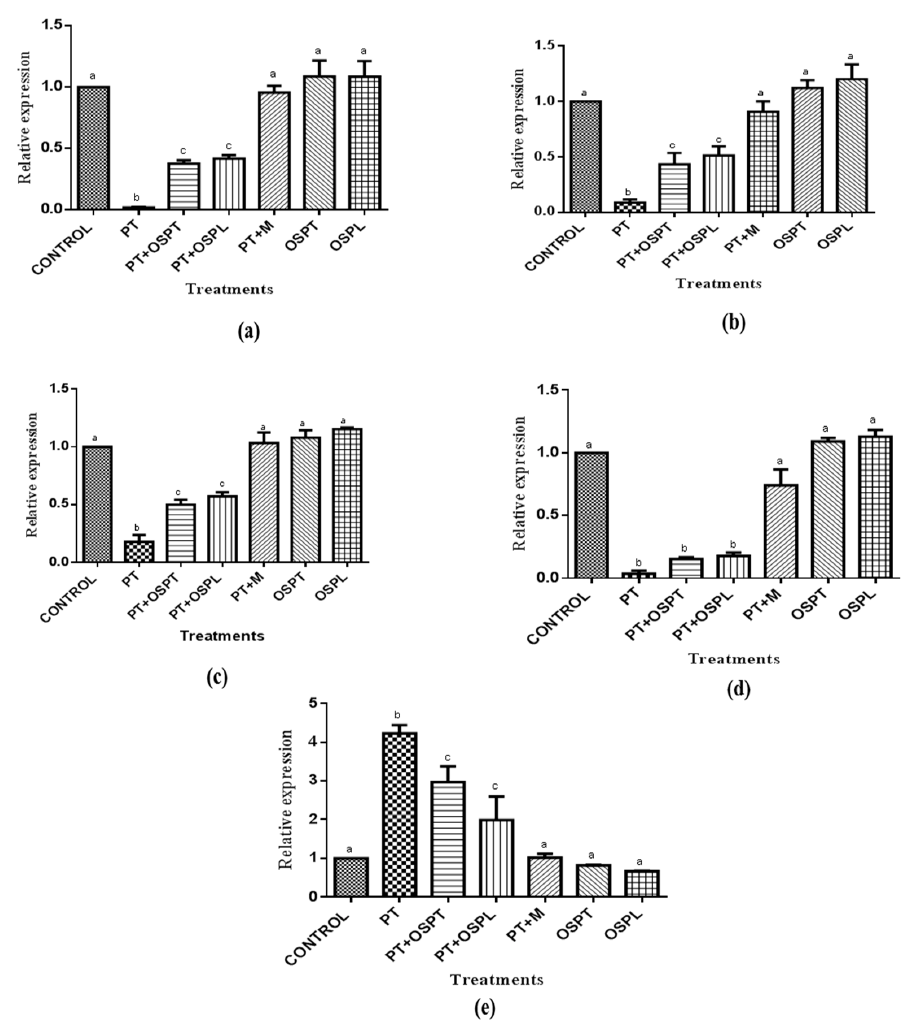
Figure 4. The effect of orange fleshed sweet potato extracts on the expression of ( a ) Glucose transporter 4 ( glut4 ) ( b ) Nuclear respiratory factor 1 ( nrf1 ) ( c ) Mycocyte enhance factor 2A ( mef2a ) ( d ) Carnitine palmitoyl transferase 1 ( cpt1 ) and ( e ) Acetyl CoA carboxylase 2 ( acc2 ) in treated C2C12